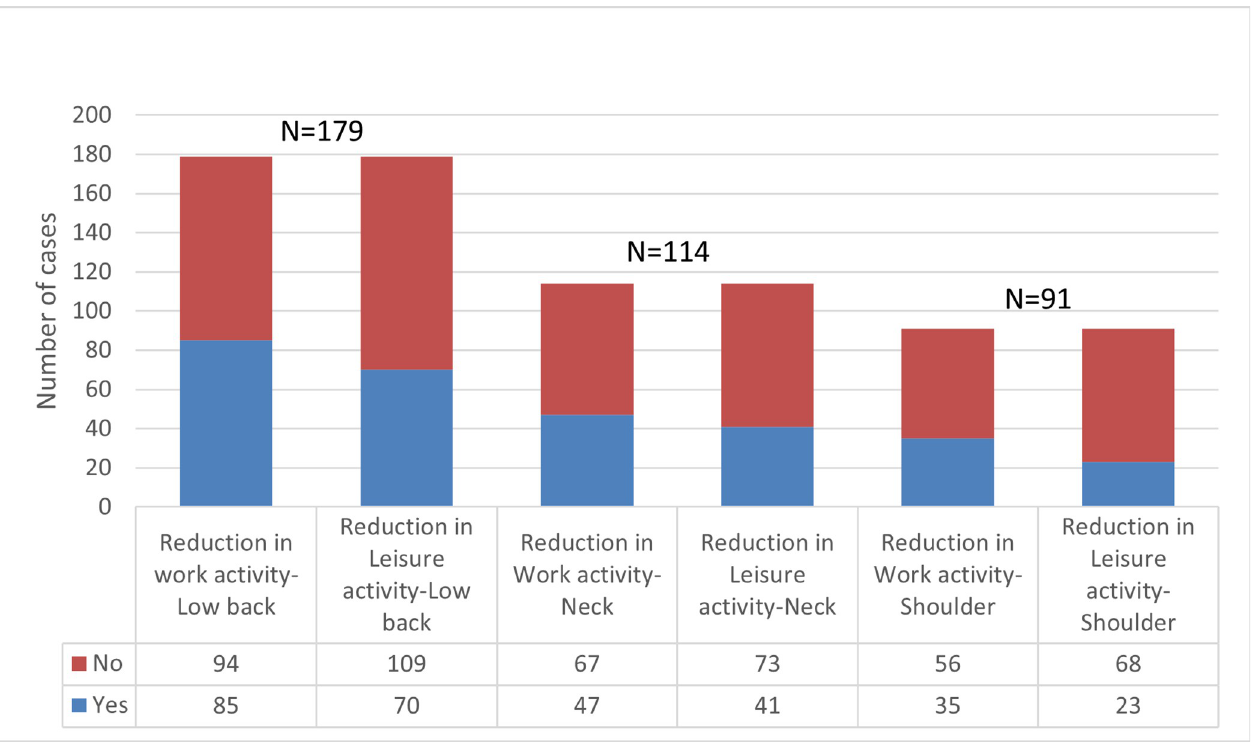
Fig 3. Reduction of daily activities among study participants experiencing musculoskeletal problem.